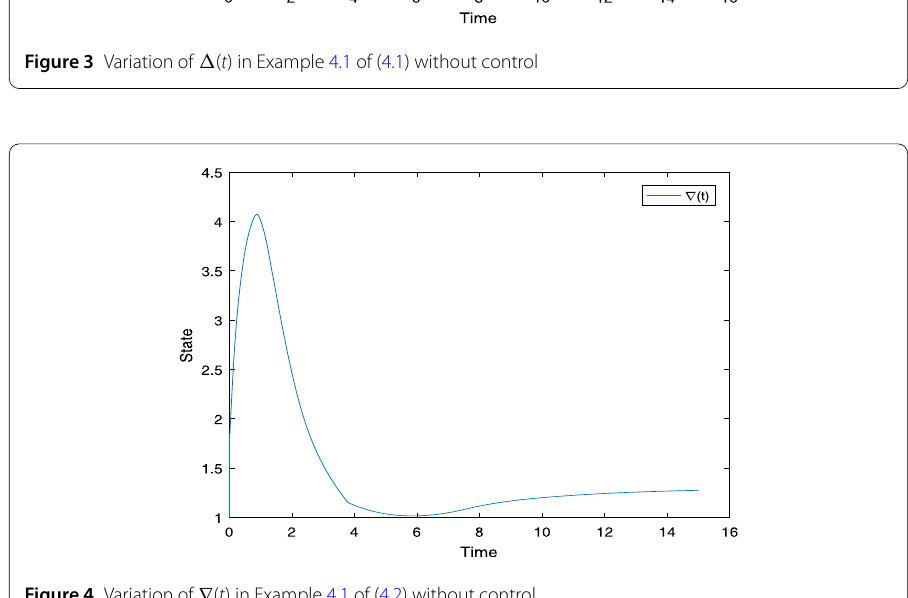
Figure 4 Variation of ∇ ( t ) in Example 4.1 of (4.2) without